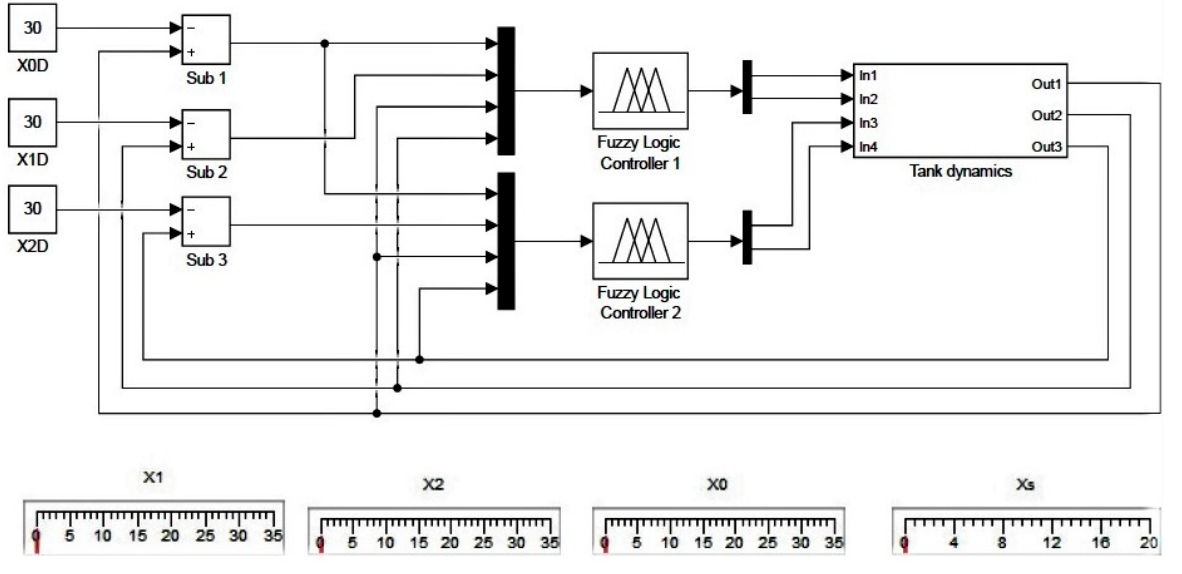
Figure 4. Fuzzy Control Scheme in Simulink.